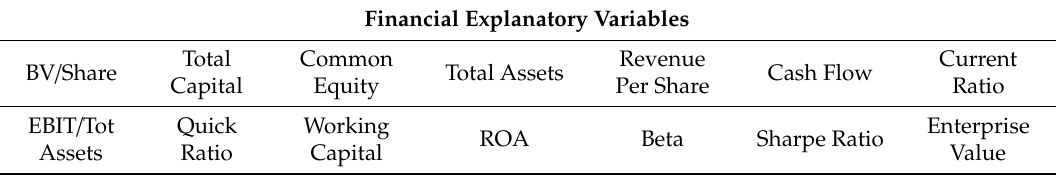
Table 3. Financial explanatory variables used in the study.